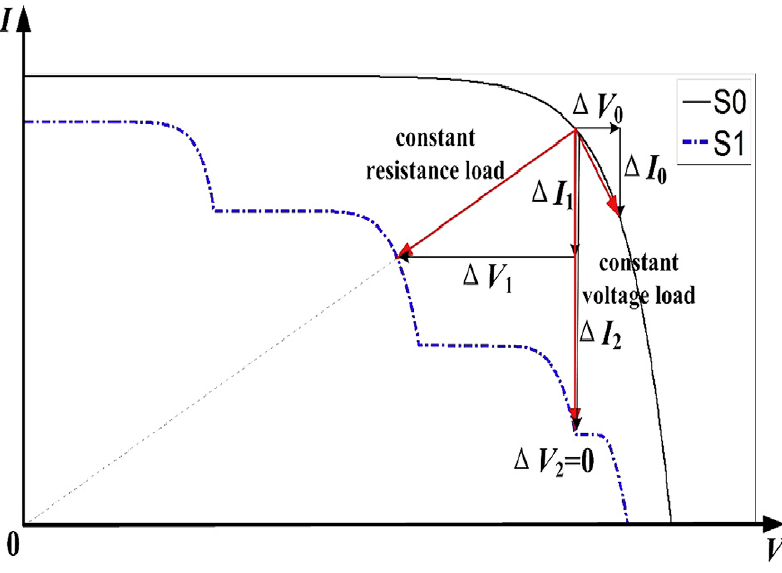
Figure 12. Comparison of the current and voltage of the PV array under uniform and non-uniform irradiance conditions [50].